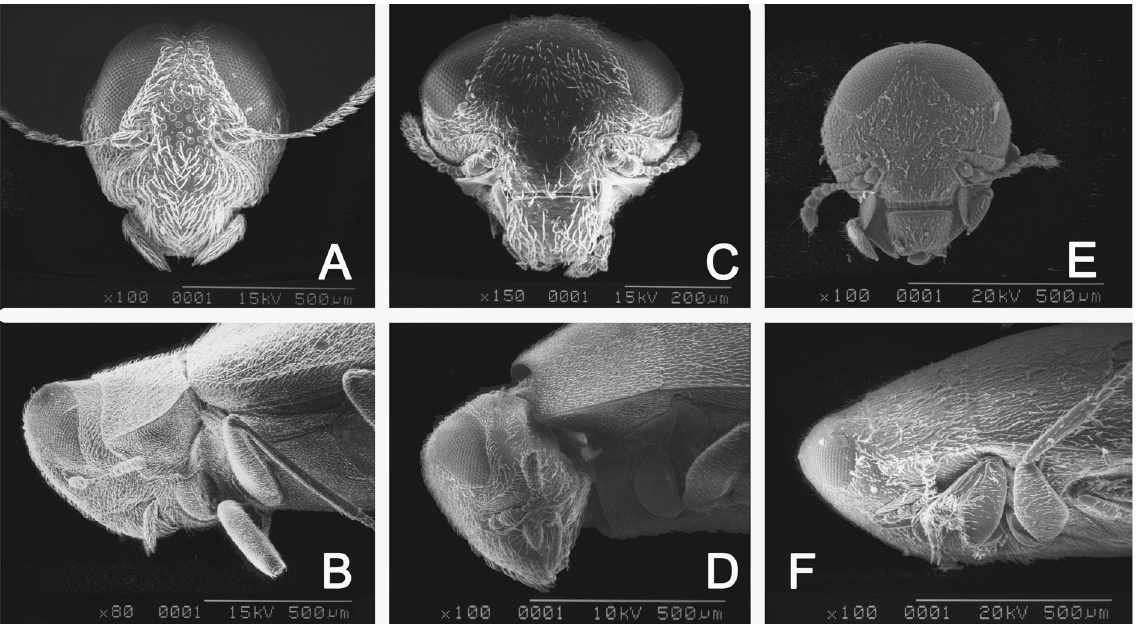
Fig. 2. Head in frontal (A, C, E) and lateral (B, D, F) views. A, D . Acontosceles chujoi Yoshitomi & Satô, 2005. B, E . Mexico masamii (Satô, 1994). C, F . Pseudeucinetus zygops Heller,